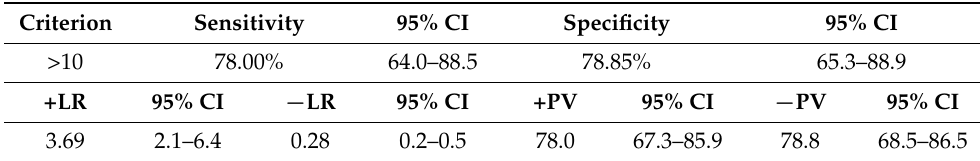
Figure 4. Predictive values in the ROC curve analysis. Table 5. Predictive values of the Short Form of the Fonseca Anamnestic Index to diagnose cases of Temporomandibular disorder.